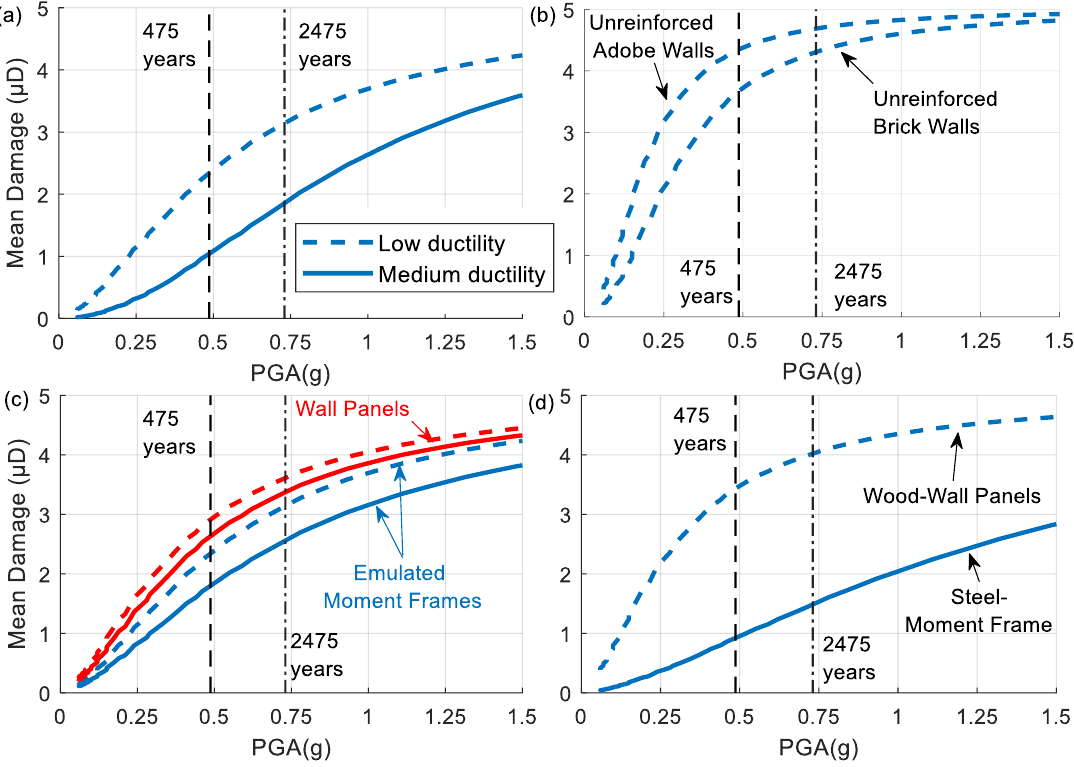
Figure 5. Mean damage vs. PGA for different groups of residential buildings: ( a ) reinforced concrete shear wall; ( b ) masonry; ( c ) precast concrete; and ( d ) steel and wood.